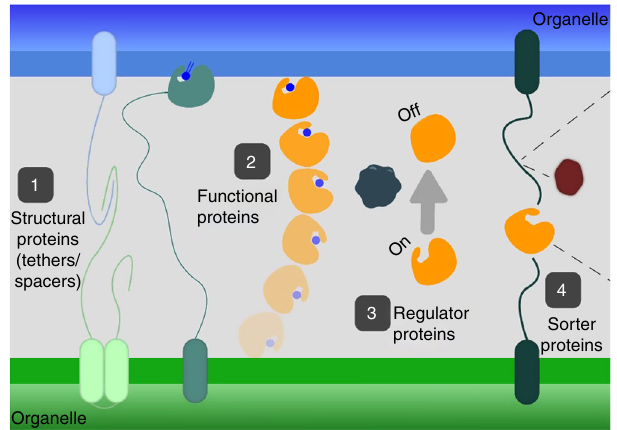
Fig. 1 Graphical representation of the four types of proteins that should reside in contact sites. Importantly, many proteins can have multiple roles at a contact